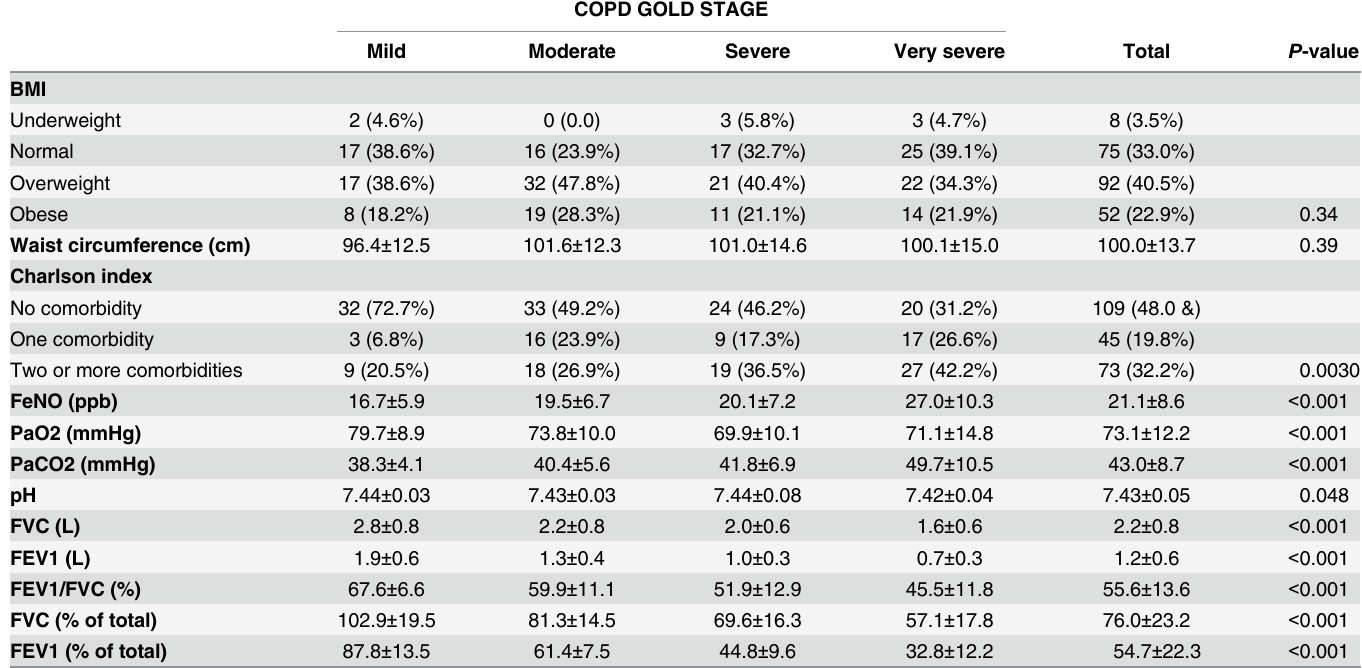
Table 2. Clinical and anthropometric characteristics in COPD population.